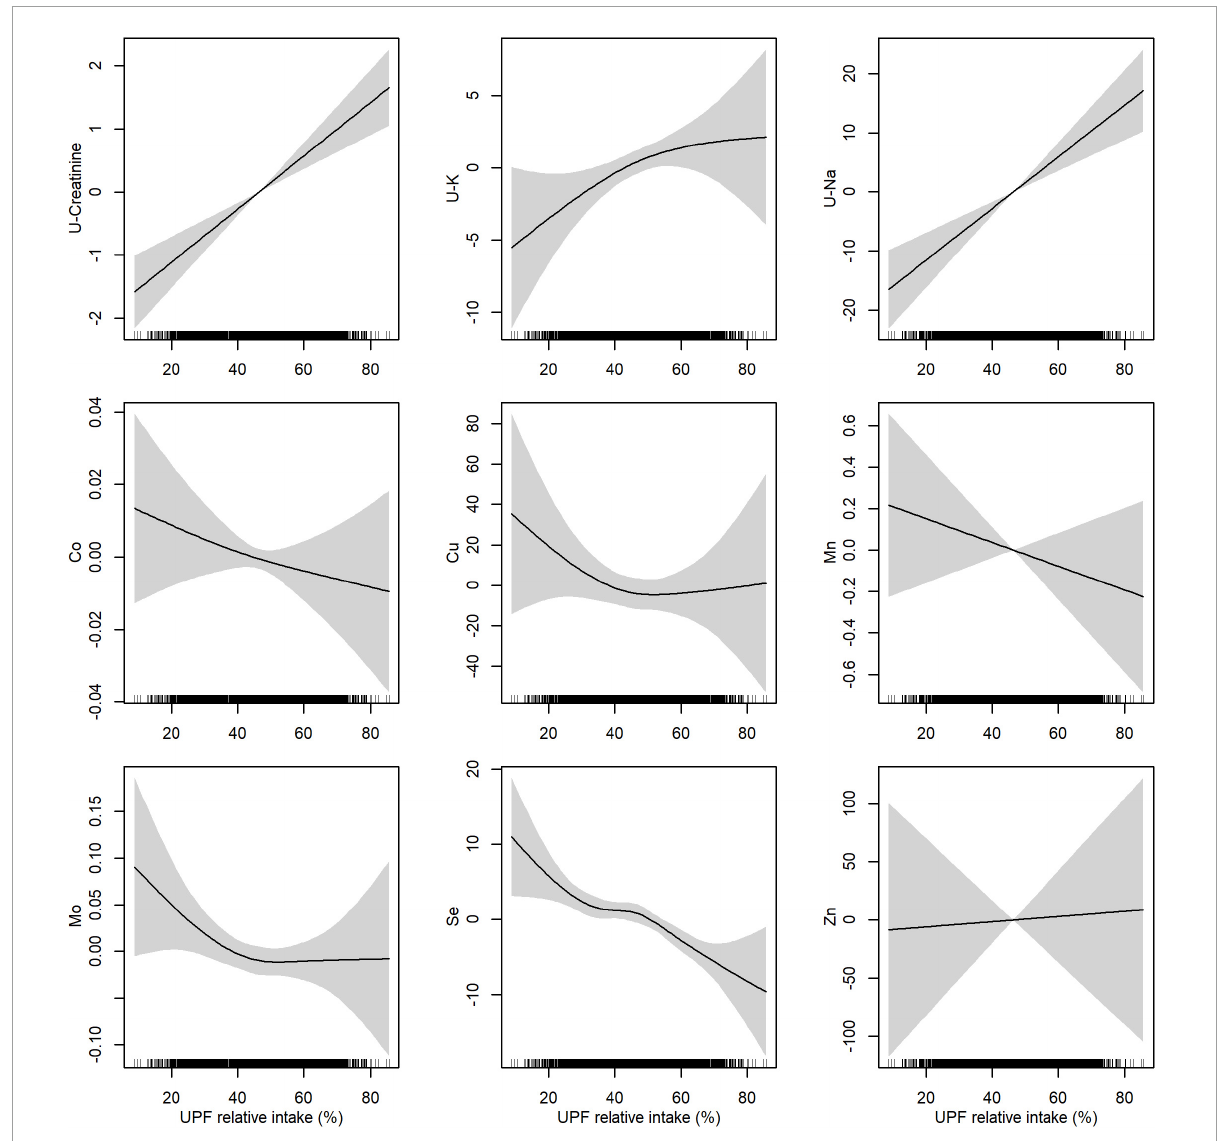
FIGURE4 Adjusted associations between relative intake of ultra-processed food (UPF) and biomarkers measured in urine (indicated by “U-”) and whole blood. Associations were estimated by non-parametric generalized additive models using a restricted cubic spline with five knots as smoother. Adjusted for age at delivery, parity, pre-pregnancy BMI, education level, alcohol intake, and smoking